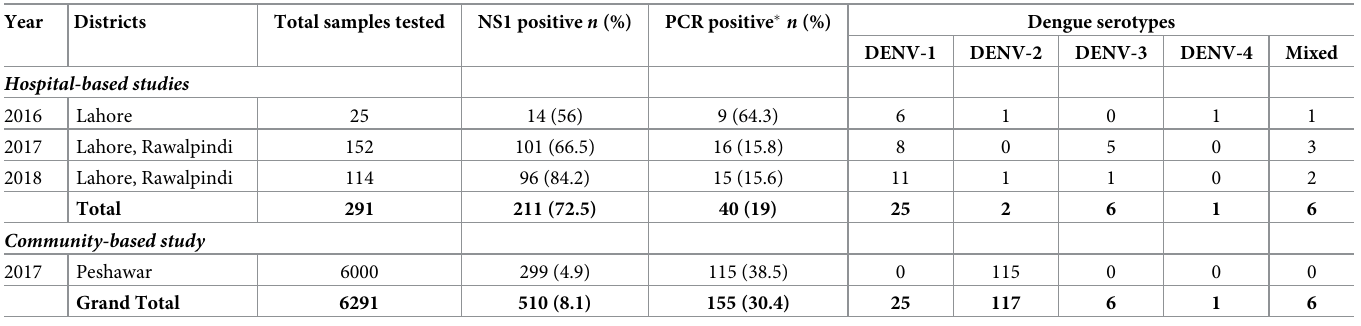
Table 4. Prevalence of DENV serotypes in Lahore, Rawalpindi, and Peshawar districts in